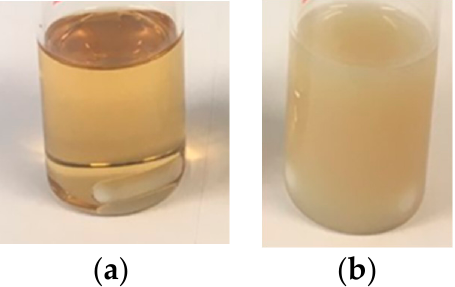
Figure 2. 1 wbm% of CeO 2 nanoparticles dispersed in 2-OA/IBOMA ( a ) and in 2-OA/IBOMA/AA ( b ). The morphology of the hybrid polymer particles and the film shown in Figure 1